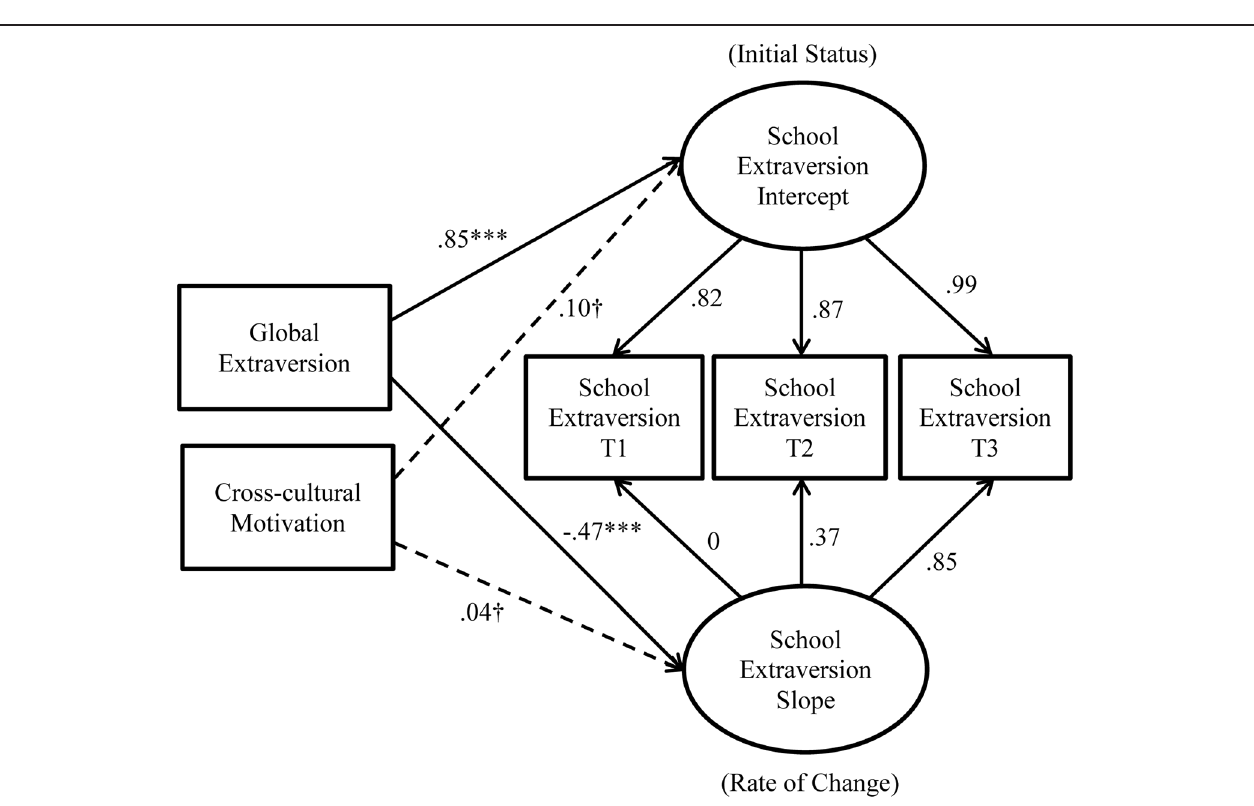
FIGURE 3 | Results from the modified Model 1 with the predictors and school extraversion change. ∗ p < 0.05; ∗∗ p < 0.01; ∗∗∗ p < 0.001; † p ≥ 0.05; N = 215. Estimates are standardized estimates from the modified Model 1 (i.e., the constrained model). Solid lines represent significant paths, whereas dotted lines represent insignificant paths.